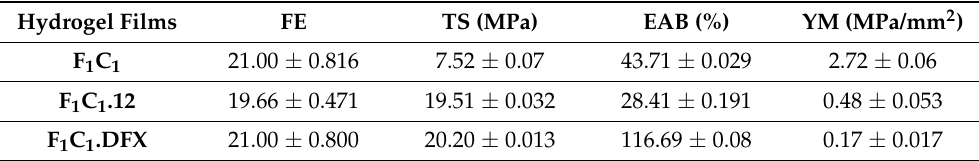
Table 4. Mechanical properties of the biocomposite hydrogel